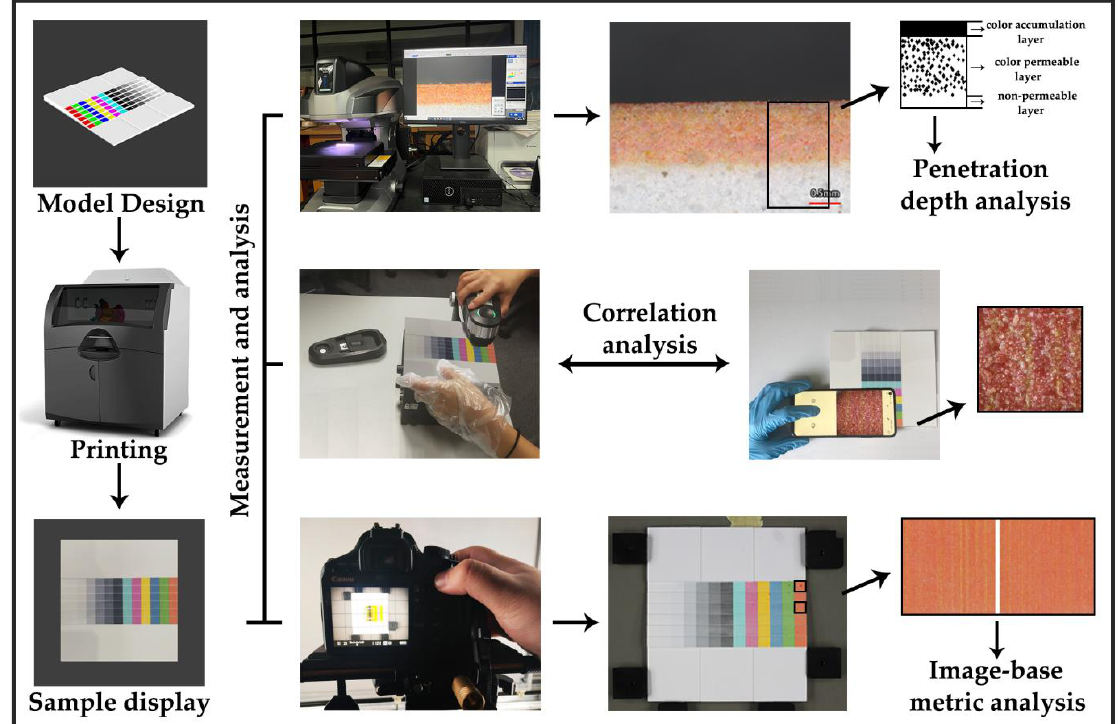
Figure 1. The experimental framework with relative equipment.